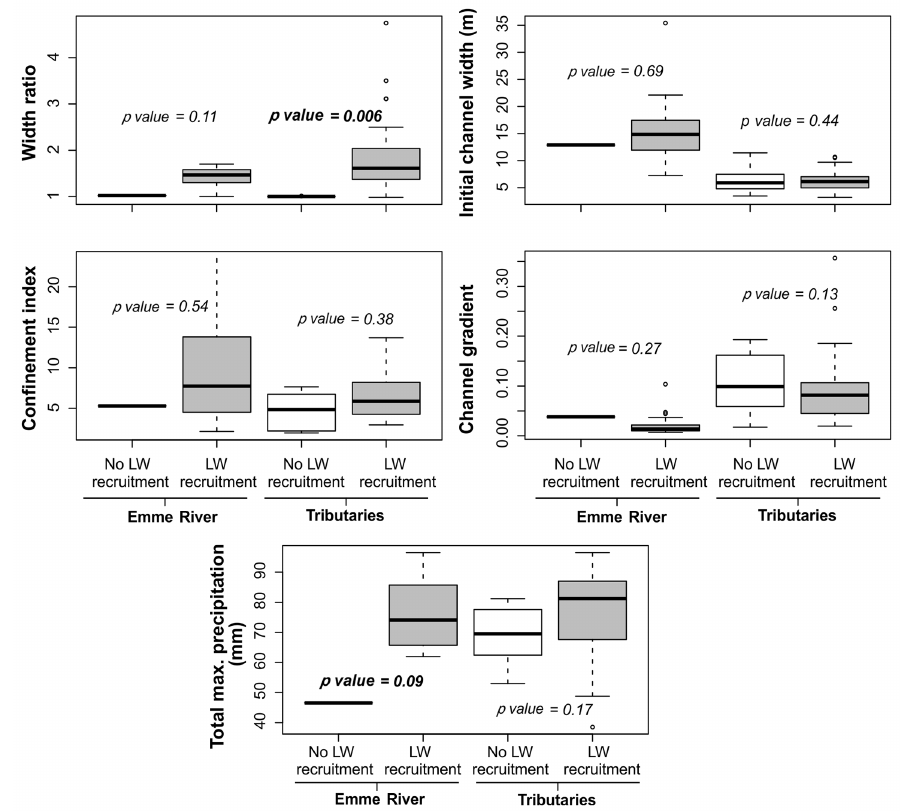
Figure 8. Box plots of morphological characteristics (width ratio, initial channel width, confinement index, channel gradient, and total max. precipitation of sub-reaches showing wood recruitment and not showing LW recruitment). The bottom and top of the box indicate the first and third quartiles, respectively, the black line inside the box is the median, and circles are outliers. The Wilcoxon signed rank test result ( p value) for the significance of differences is also shown; bold indicates significant